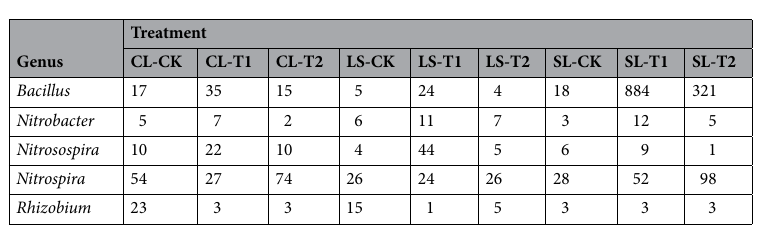
Table 5. Estimated OTUs of major N transformation bacteria at the genus level of the 16S rRNA gene libraries for clustering at 97%